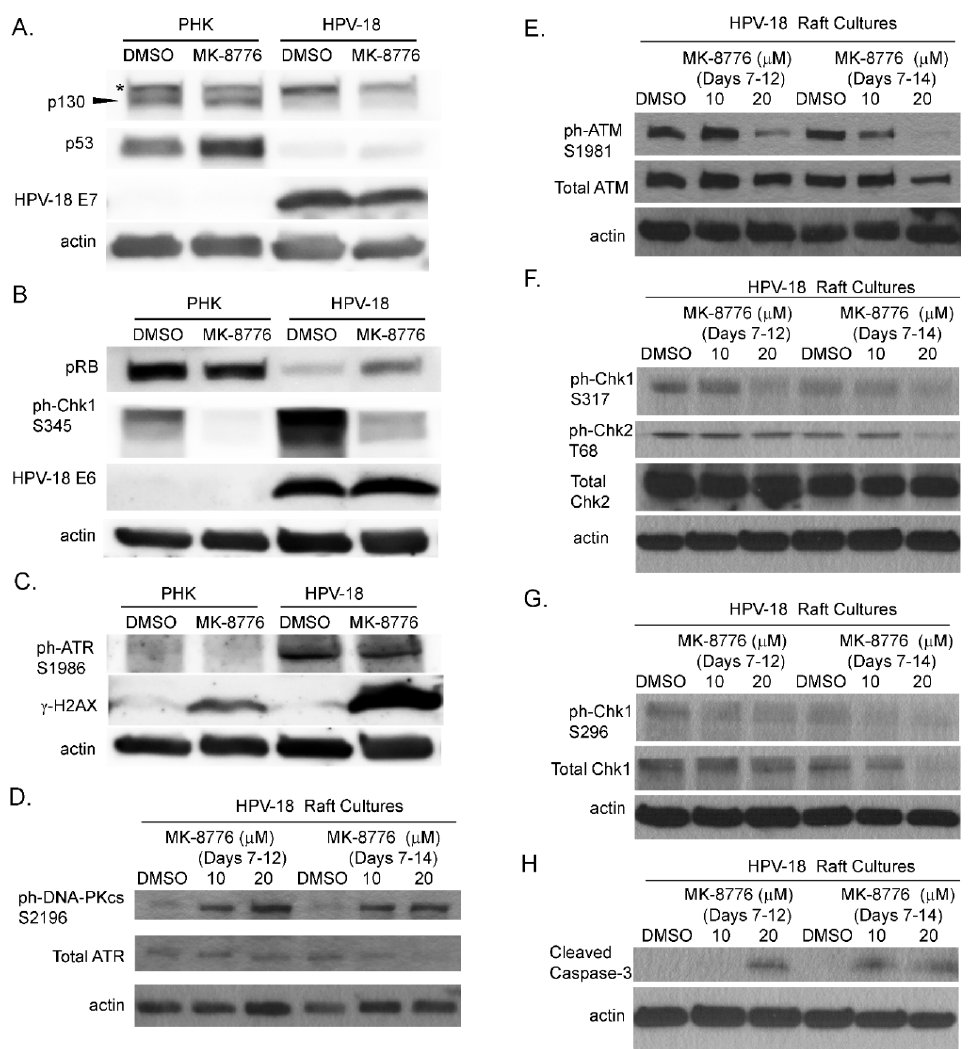
Figure 2. Effects of MK-8776 exposure on HPV-18 E6 and E7 and DNA damage response (DDR) proteins, as well as a biomarkers of DNA damage and apoptosis in raft culture lysates. ( A – C ) Uninfected (PHK) and infected (HPV-18) raft cultures were exposed to DMSO or 20 µM MK-8776 from days 7 to 12 and harvested on day 12. Lysates were probed by immunoblot assays to detect HPV-18 E6, E7, pRB, p130, p53, ph-Chk1 S345, ph-ATR S1986 and γ -H2AX S139. ( D – H ) Immunoblot analysis of lysates from HPV-18 raft cultures exposed to DMSO, 10 or 20 µM MK-8776 from days 7–12 or days 7–14 and harvested on days 12 or 14, respectively. Immunoblots were performed to detect total ATR, total ATM, ph-ATM S1981, total Chk2, ph-Chk2 T68, ph-Chk1 S317, total Chk1, ph-Chk1 S296 and cleaved caspase. Actin served as loading control for each set of immunoblots. Arrowhead points to p130 protein band. * denotes a non-specific protein detected by the p130